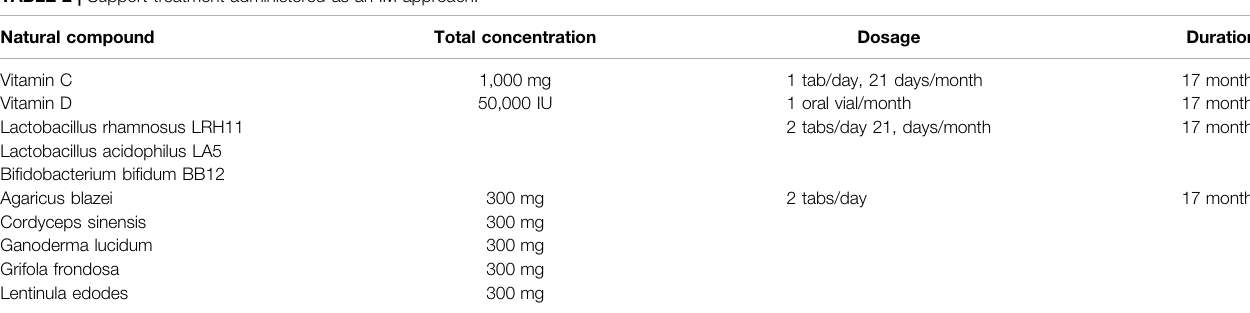
TABLE 2 | Support treatment administered as an IM